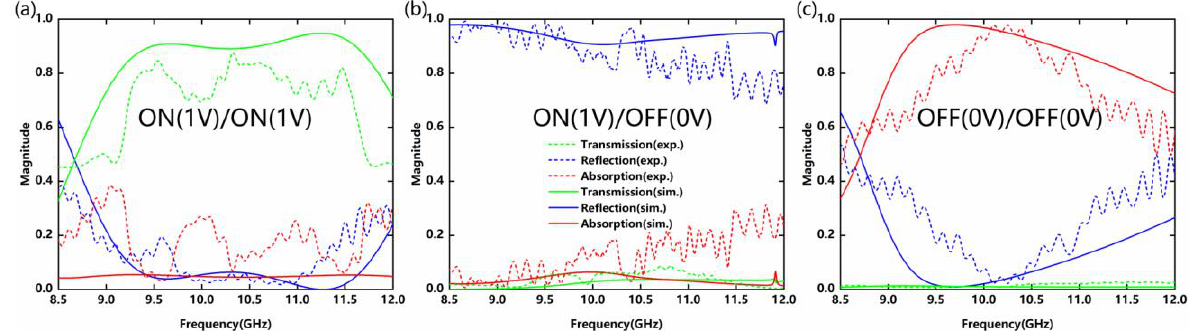
Figure 8. Simulated and measured reflection/transmission characteristics of the proposed metadevice under different operation modes ( a ) Transmission; ( b ) Reflection; and ( c ) Absorption.